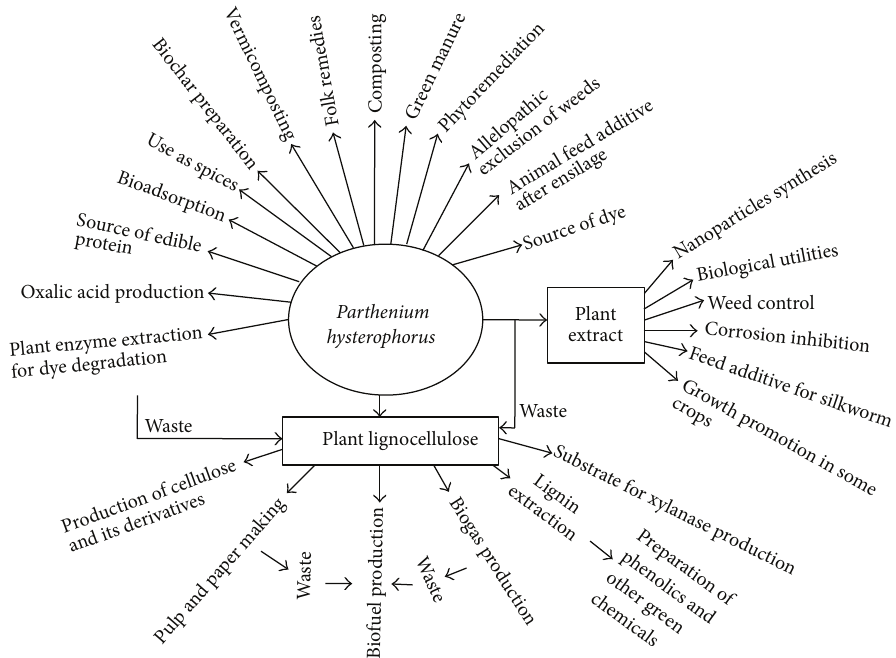
Figure 2: Utility potential of Parthenium hysterophorus